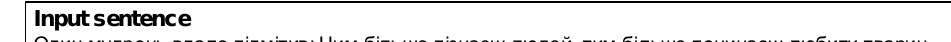
Figure 14. Creativity of the neural network.